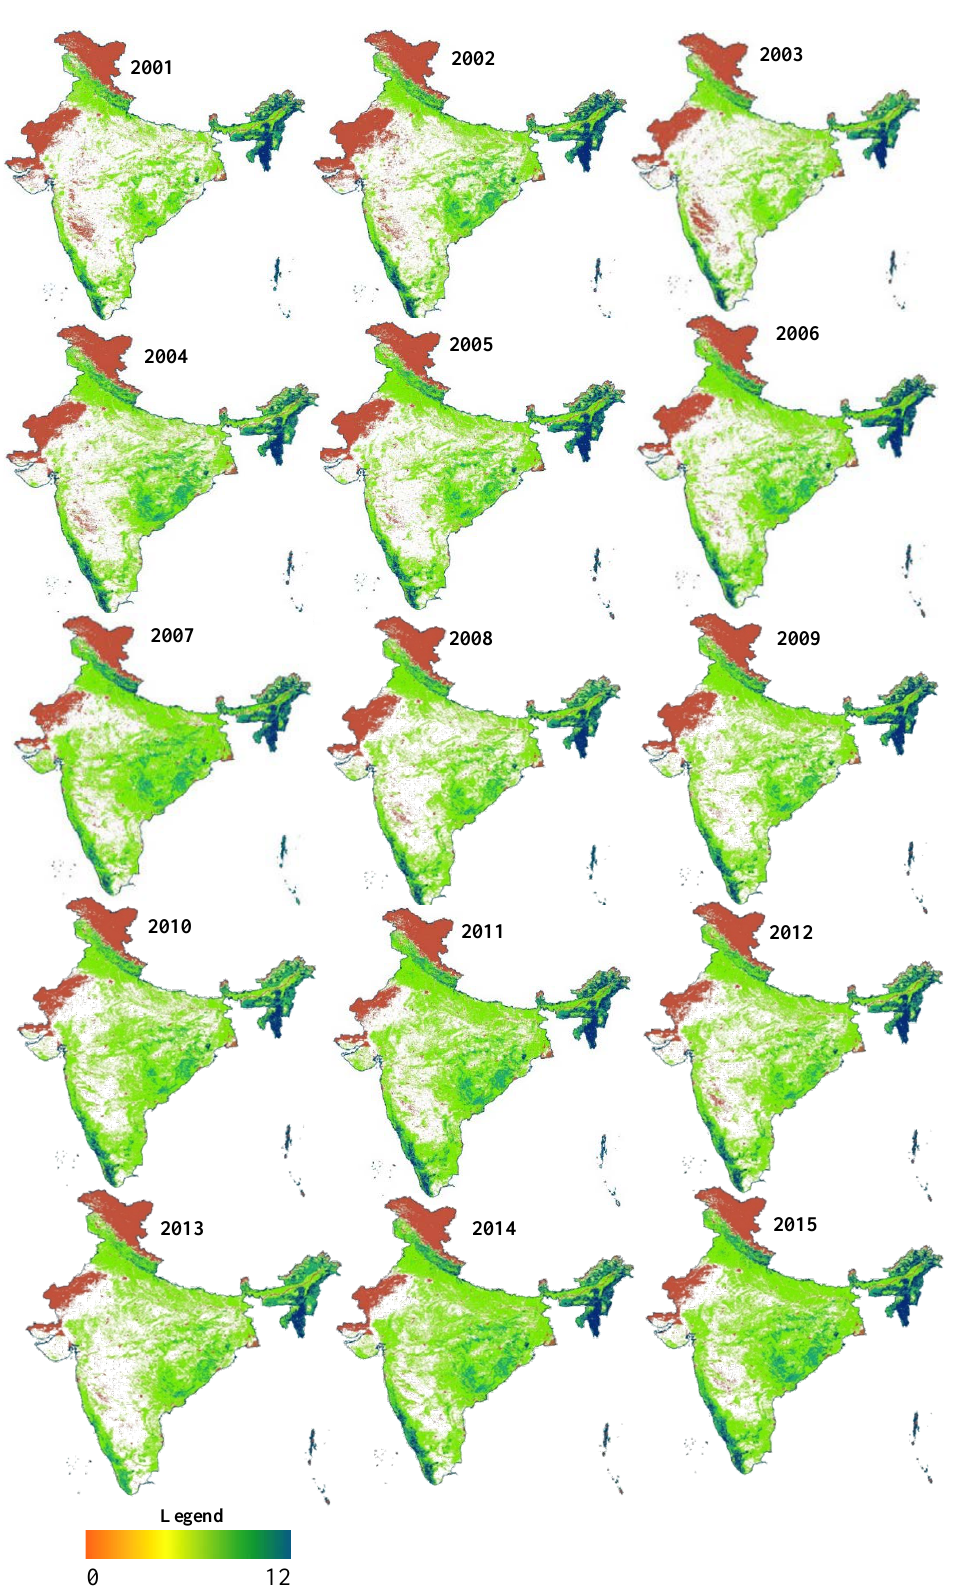
Figure 2. Cumulative dynamic habitat index (DHI-cum) derived from the monthly sum of FAPAR for a particular year is utilized to map the variation in annual greenness from 2001 to 2015 in